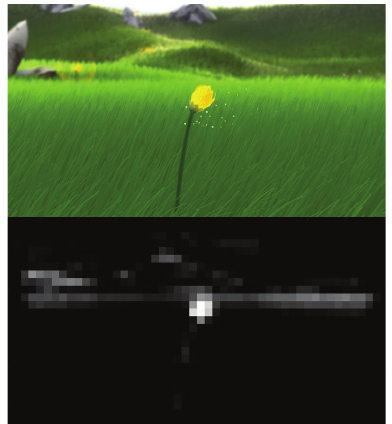
Figure 5: One of the images and its conspicuity map, Sony Com- puter Entertainment. Thatgamecompany, Bluepoint Games, 2009.